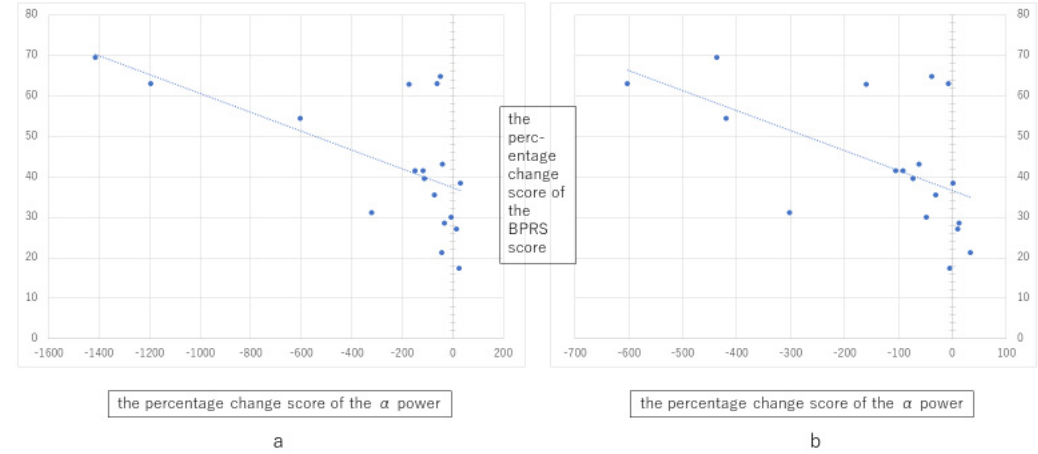
Figure 4. Scatterplots showing the relationship between percent change in BPRS total score and ( a ) percent change in alpha 1 power and ( b ) percent change in alpha 2 power. The X-axis is the percentage change score in alpha power and the Y-axis is the percentage change score in BPRS score.